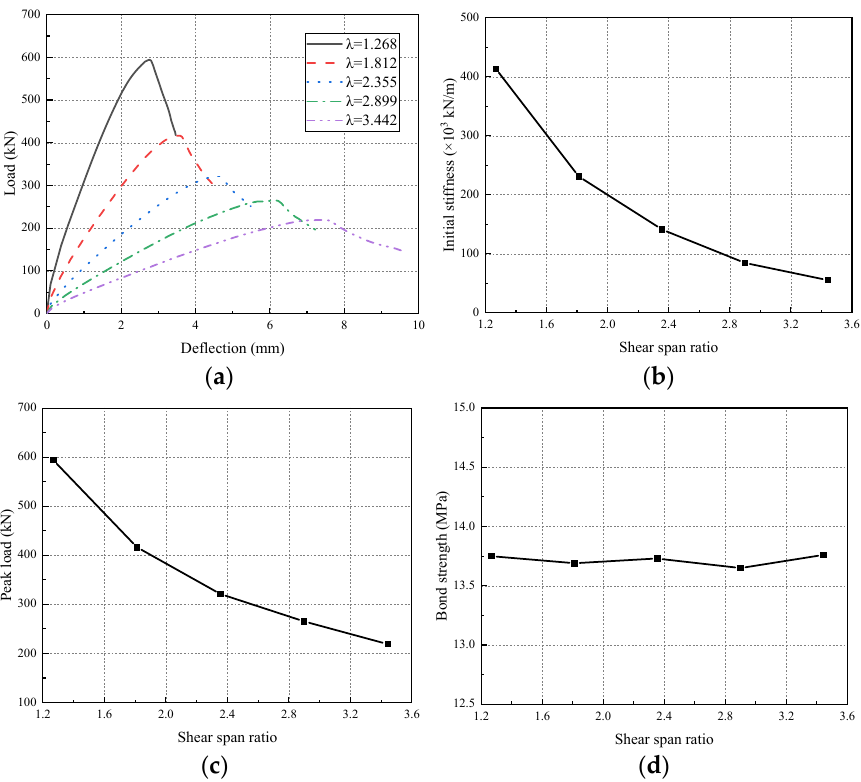
Figure 21. Influence of shear span ratio: ( a ) load–deflection curve; ( b ) initial stiffness; ( c ) peak load; ( d ) bond strength.